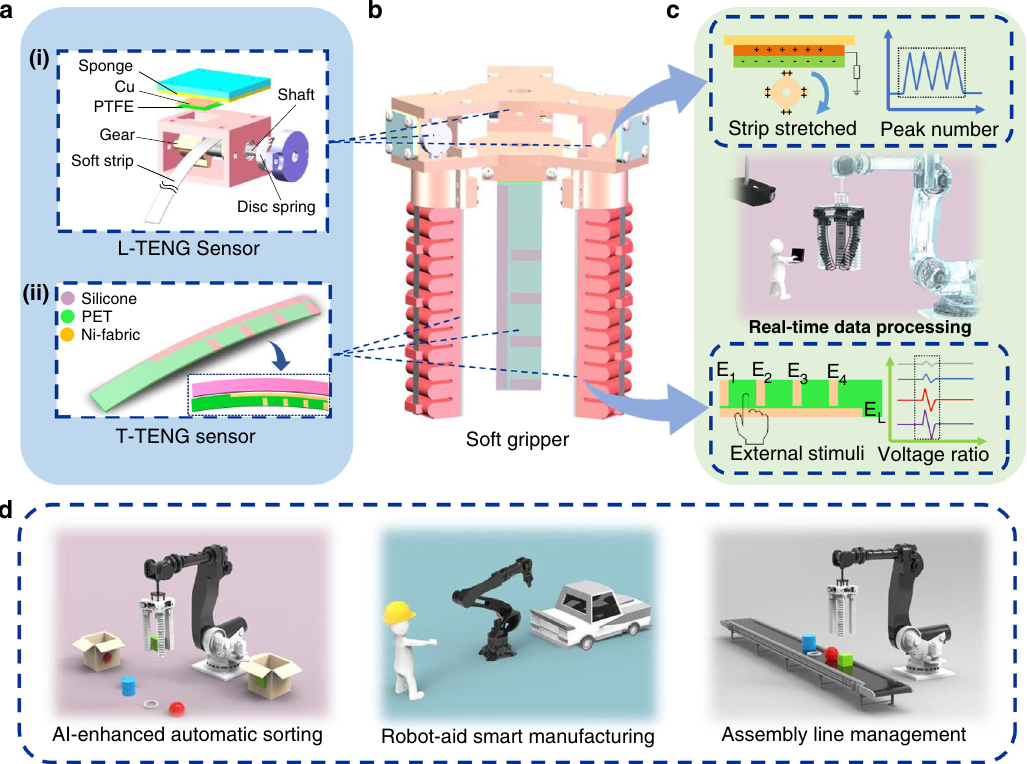
Fig. 1 Construction drawing of the low-cost triboelectric nanogenerator (TENG) for soft gripper and its digital twin applications. a The as-fabricated TENG sensors and their basic structures. (i) The length TENG (L-TENG) sensor and (ii) the tactile TENG (T-TENG) sensor. b The soft gripper integrated with TENG sensors. c The intelligent sensory data processing strategies. E 1 to E 4 , and E L represent the electrodes in the T-TENG sensor. d The digital twin applications based on arti fi cial intelligence of things (AIoT) sensory